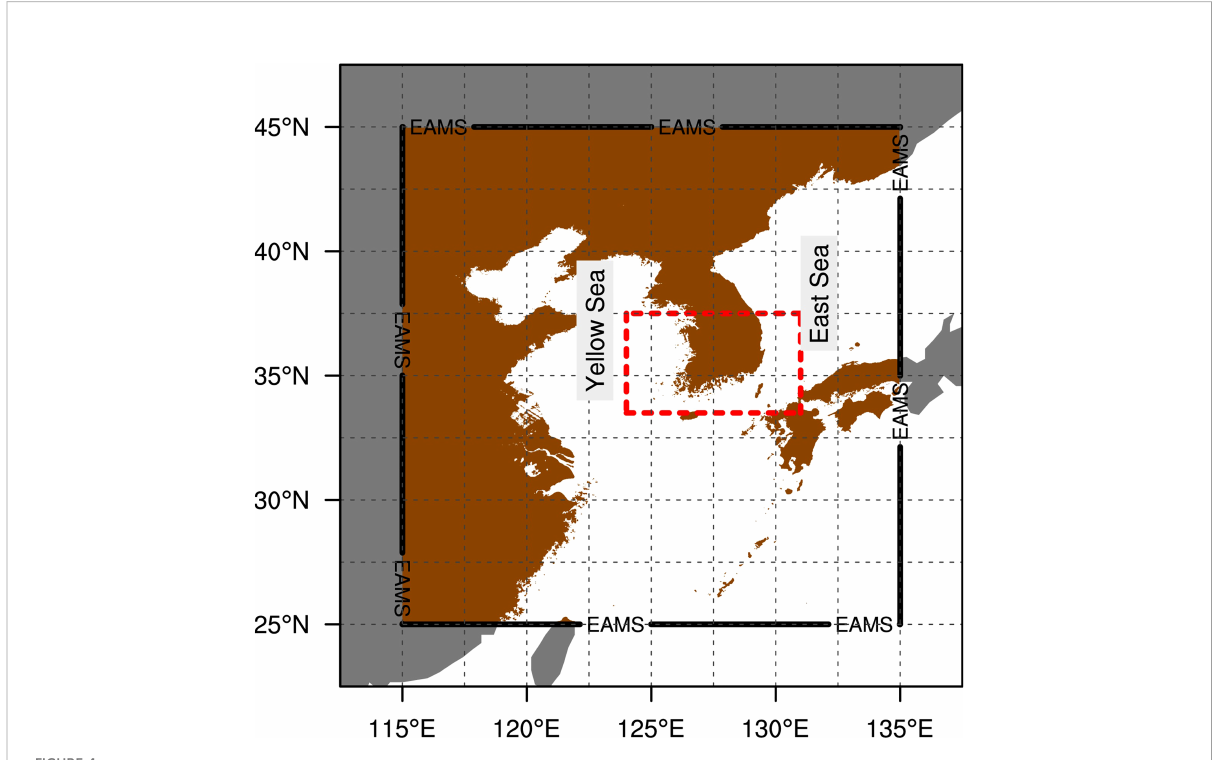
FIGURE 4 Model domain for the Weather Research and Forecasting (WRF) and Regional Ocean Modeling System (ROMS) models. The East Asia marginal seas (EAMS) and the analysis region are shown with a solid black line and a red dotted line,